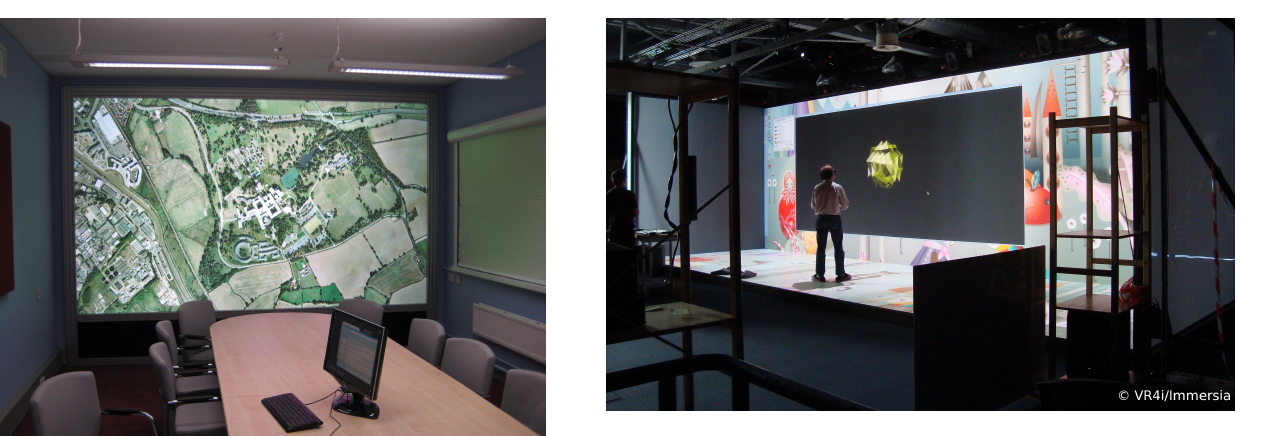
Fig. 3. One of the CAVEs at INRIA collaborative interaction and modeling of virtual